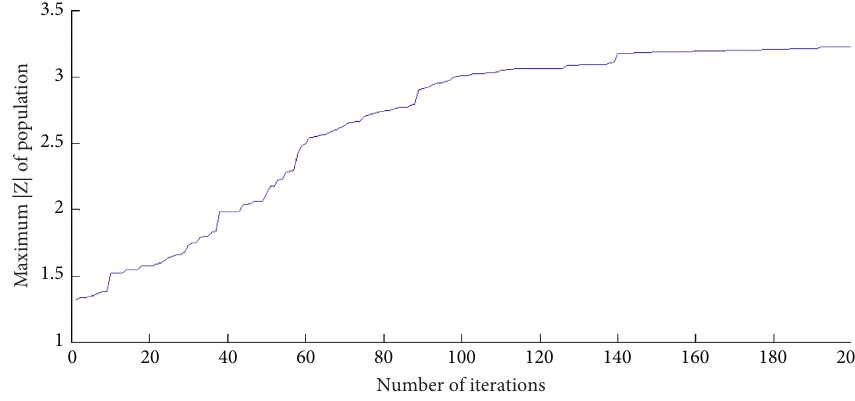
Figure 7: The maximum |Z| of SRR in iterations of GA.